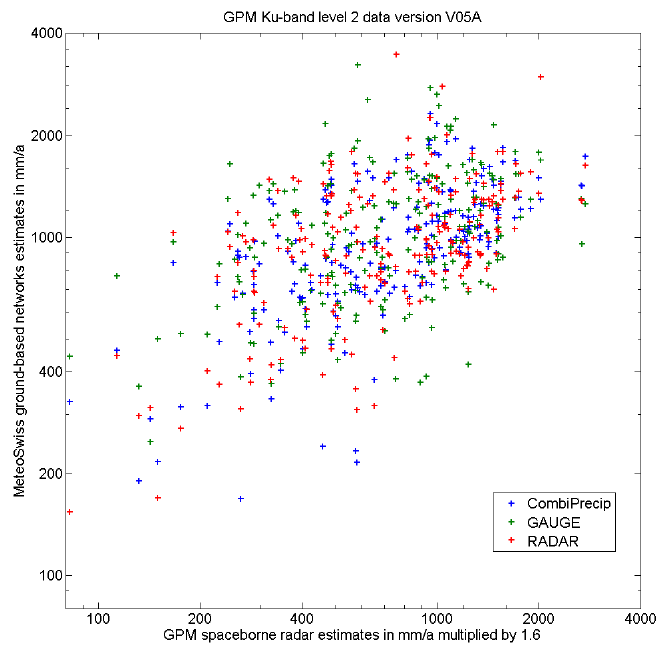
Figure 2. GPM spaceborne radar (V05A) annual precipitation estimates (multiplied by 1.6) versus the estimates from three MeteoSwiss products: RADAR (red), GAUGE (green), and the geostatistical merging of the two (CombiPrecip). Note that the multiplication of the GPM values by 1.6 on the x axis means a visual compensation of 2 dB (out of ~3 dB overall underestimation by GPM) in the log-log scatter plot.